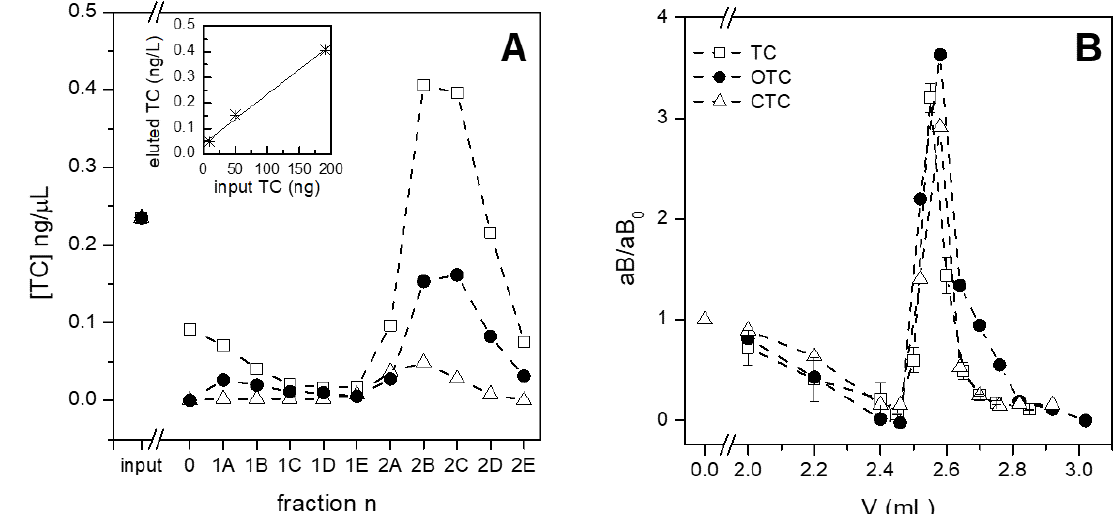
Figure 6. Test of the purification system with different amounts of tetracycline (panel ( A )) and different tetracyclines (panel ( B )). A: the same concentration of tetracycline dissolved in DPBS was injected in the 250 µL chamber containing the same amount of Cu-NTA beads for different times (white square: 16 min; solid circles: 4 min and white triangles: 1 min). Then, the chamber was fluxed with DPBS (fractions 1A–1E) and finally tetracycline was eluted with the McIlvaine buffer (fractions 2A–2E). The amount of tetracycline was quantified by HPLC. Inset: linear correlation between input and eluted tetracycline. B: Cu-NTA beads were loaded in 100 µL chambers, where the different antibiotics spiked in buffer were purified and concentrated. The reported values “aB/aB 0 ” refer to the antibiotic present in fractions normalized for the injected